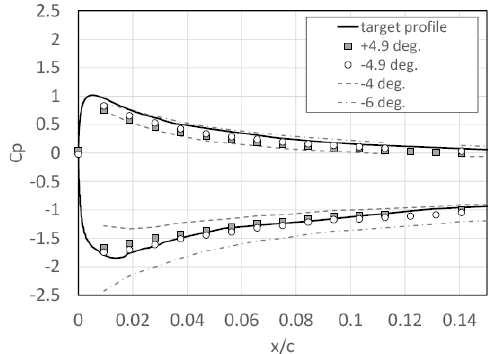
Figure 9. Pressure distribution of the leading − edge matching at AOA = 4.9°.